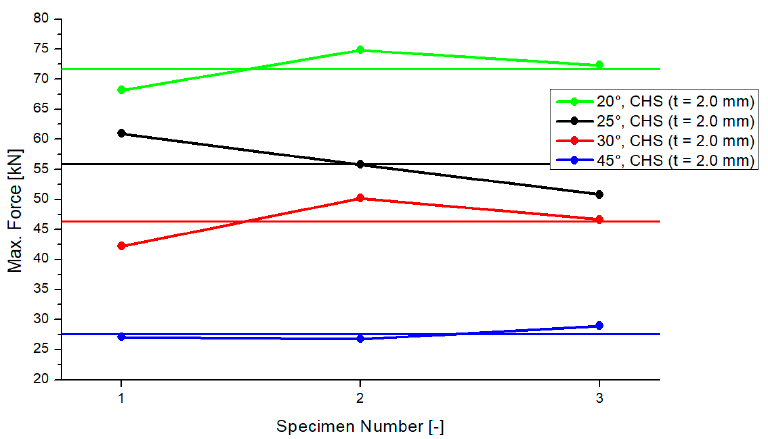
Figure 5. Results of maximum compression force, CHS t = 2.0 mm.